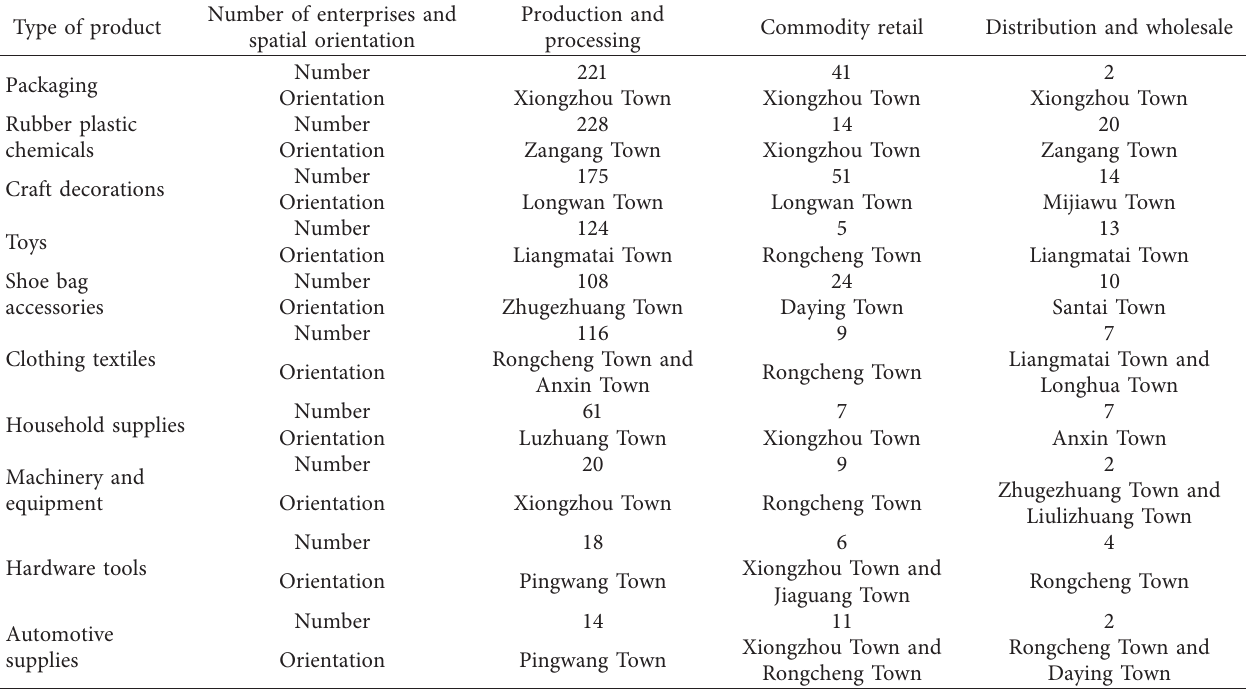
Table 2: Value chain composition and main distribution areas of major e-commerce product types in Xiong’an New Area. Type of